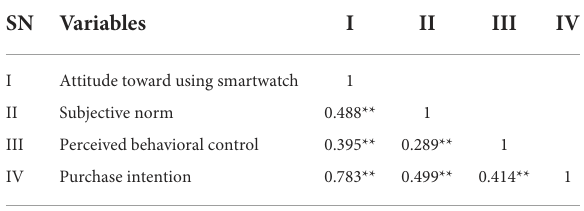
TABLE 4 Correlation (Pearson-R) between attitude toward using smartwatch, subjective norm, perceived behavioral control and purchase